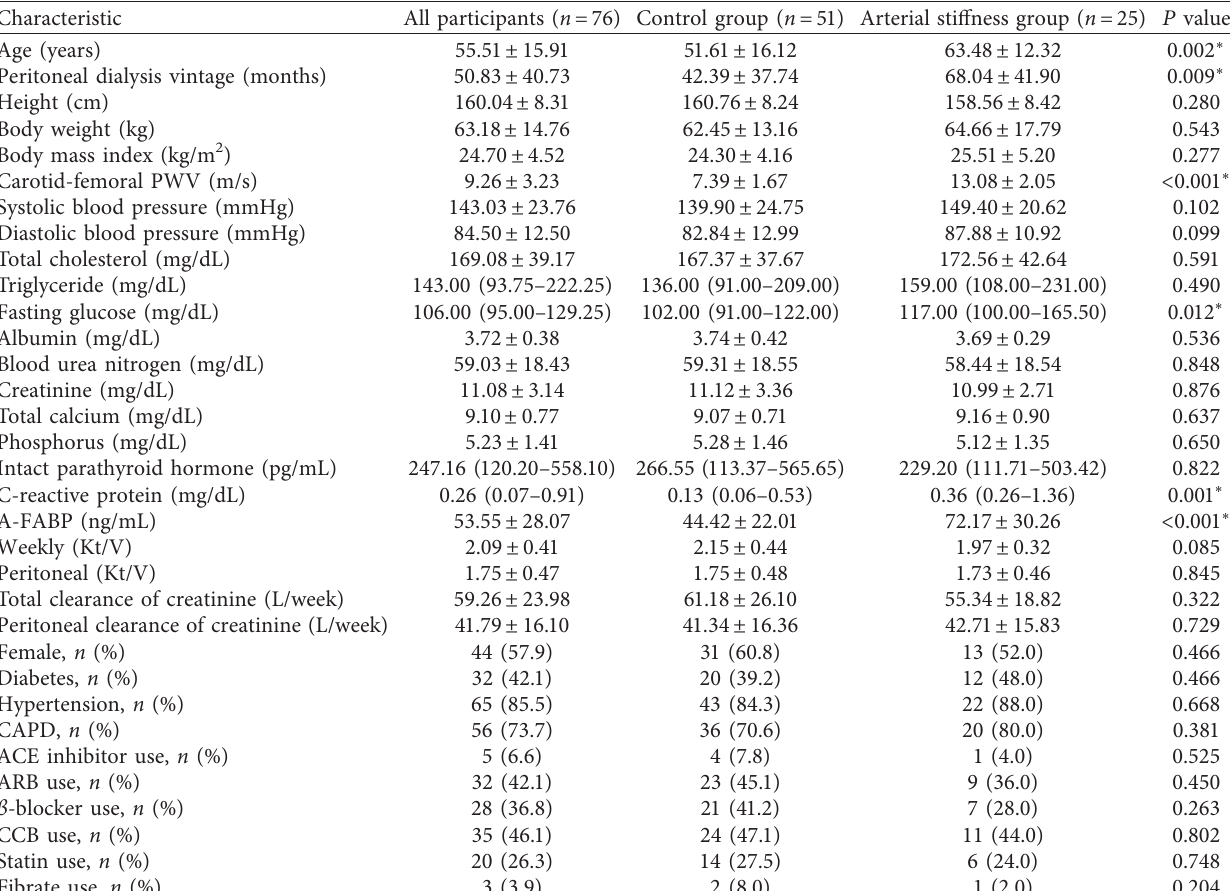
Table 1: Clinical variable of the 76 peritoneal dialysis patients with or without arterial stiffness. Characteristic